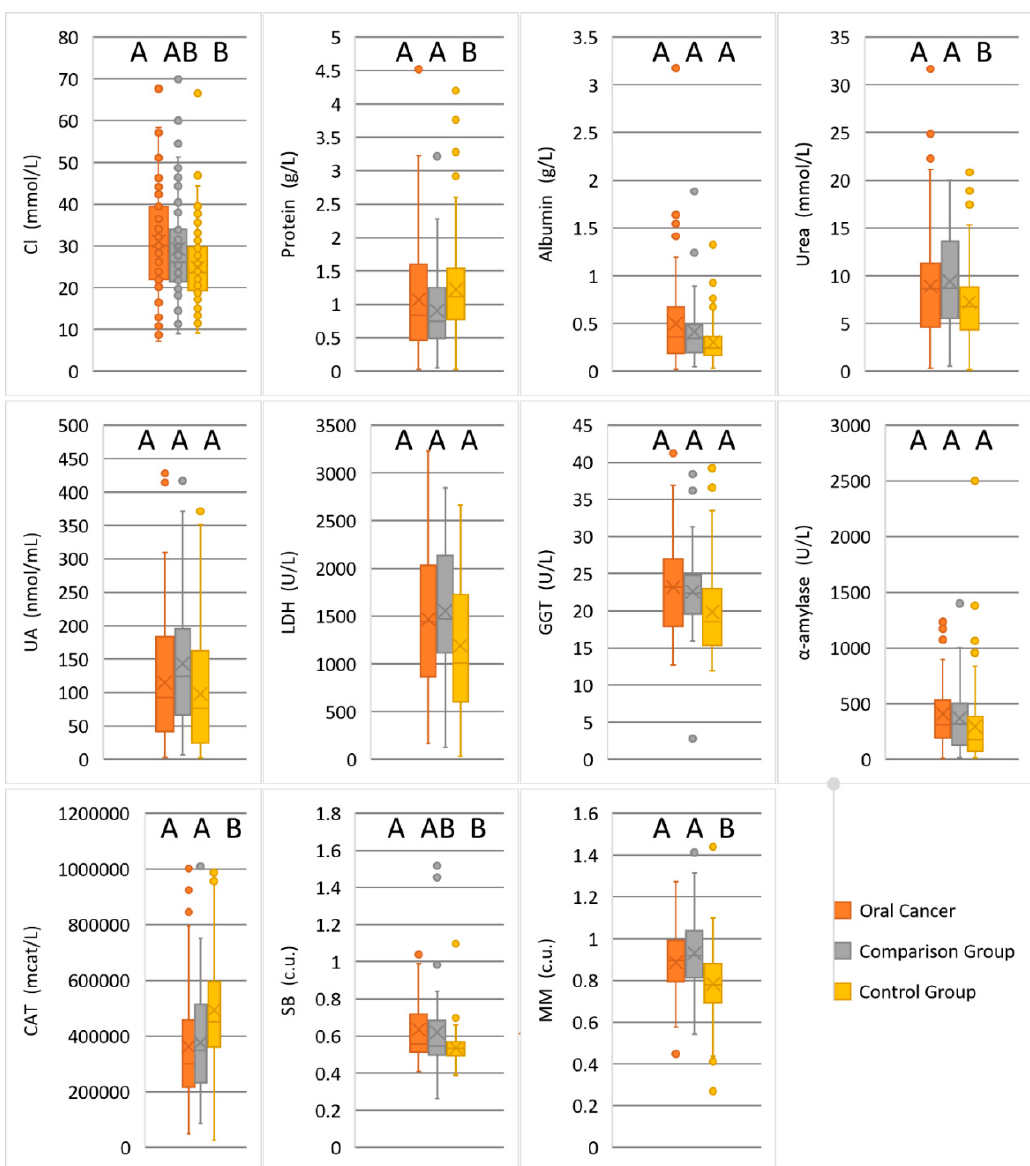
Figure 1. Comparison of statistical characteristics in the studied groups. The cross is mean; the rectangle corresponds to the first and third quartiles. The letters indicate the differences between the groups. Means without a common letter statistically differ ( p < 0.05).